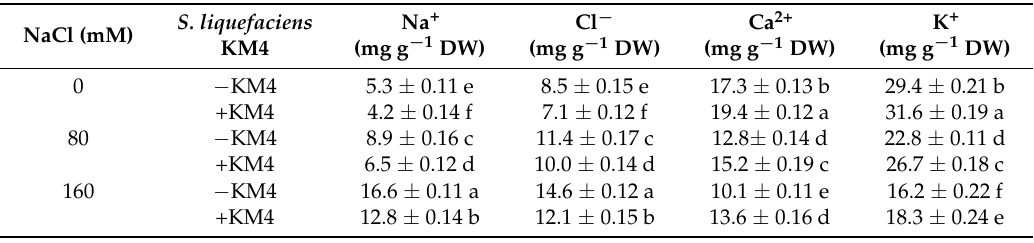
Table 2. Mineral uptake in leaves of maize plants in the presence or absence of Serratia liquefaciens KM4 under saline